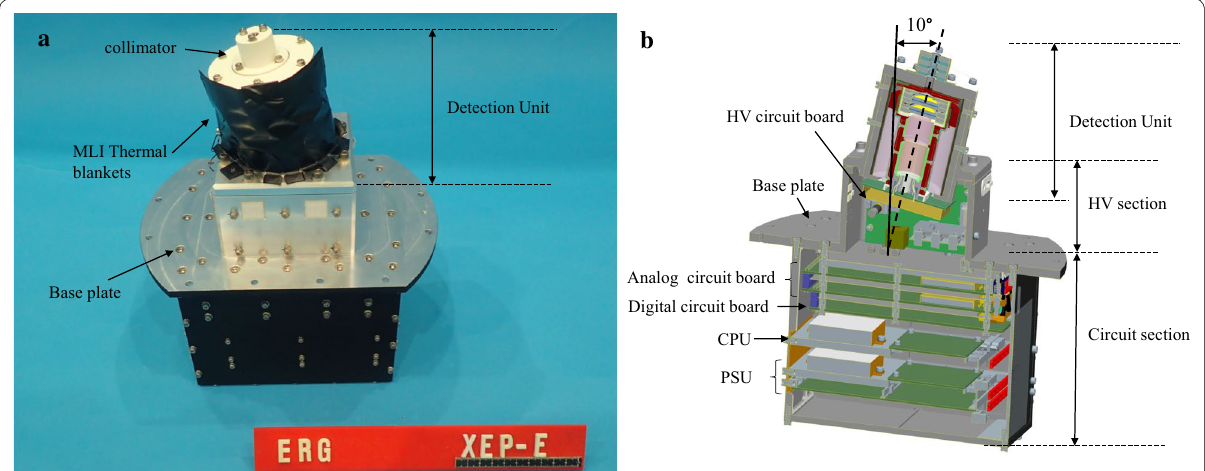
Fig. 1 a A photograph and b a cross-sectional view of the XEP flight model. The part exposed outside the spacecraft body is covered by multilayer insulation (MLI) blankets, and the detection unit is partially painted white for